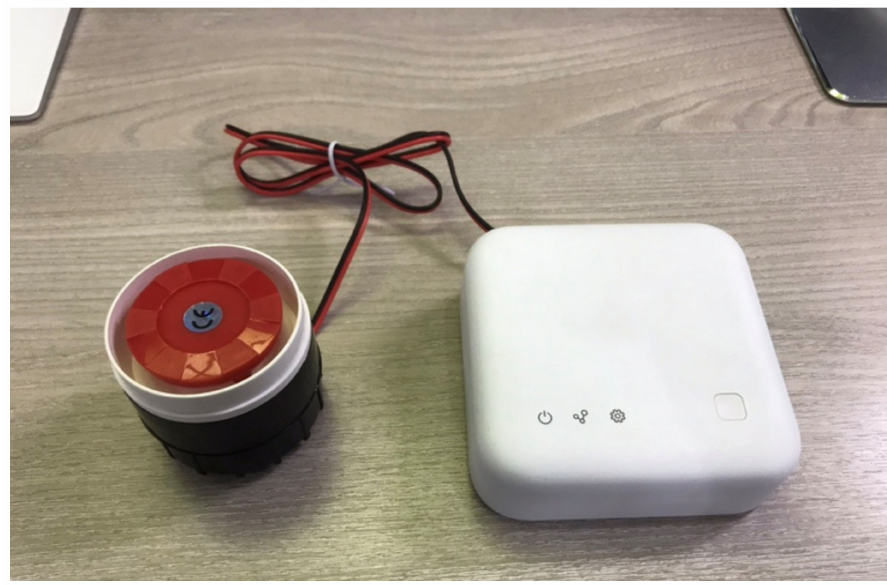
Figure 15. Gateway connected with an alert